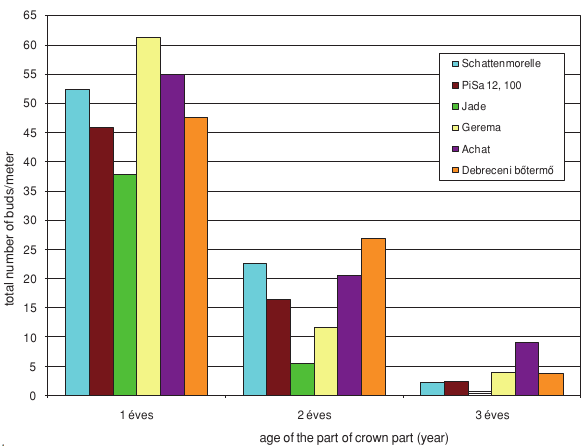
Figure 2. Number of buds grown on branches of different age on the trees ( Debrecen-Pallag, 2010)